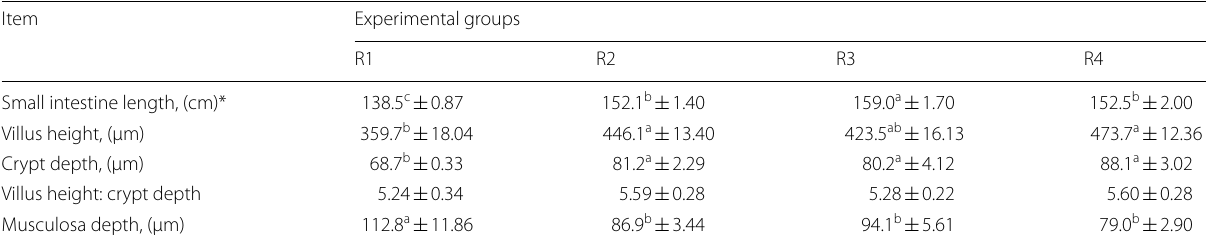
Table 4 Effect of probiotics dietary supplementation on small intestine length and histo‑morphological parameters (mean NZW rabbits